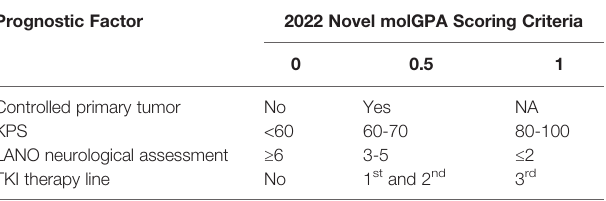
TABLE 3 | The scoring criteria of the 2022 novel molGPA. Prognostic Factor